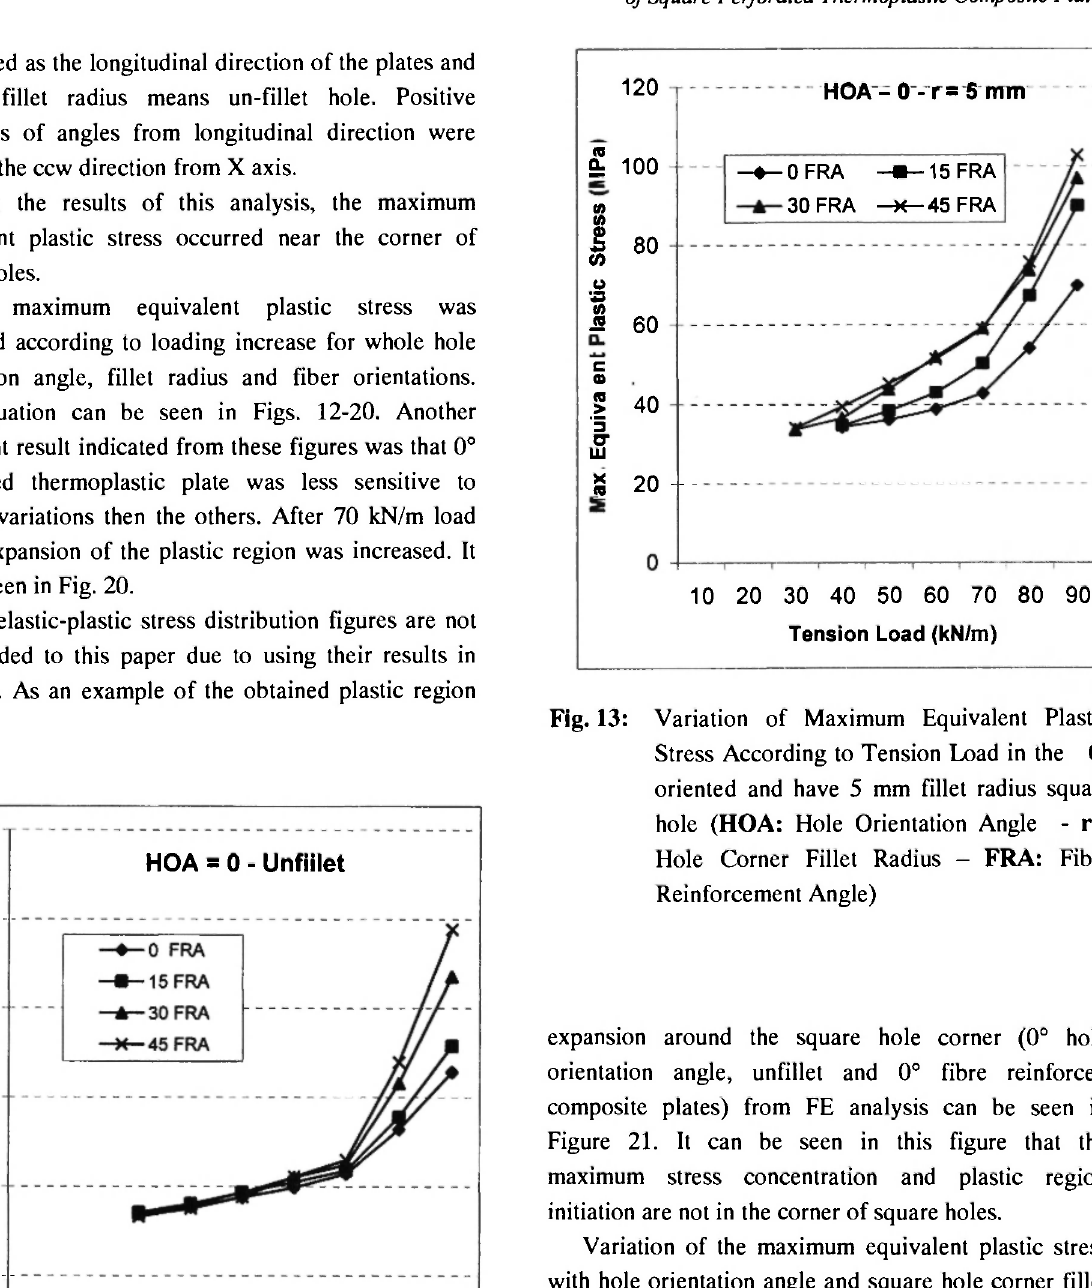
maximum stress concentration and plastic region initiation are not in the corner of square